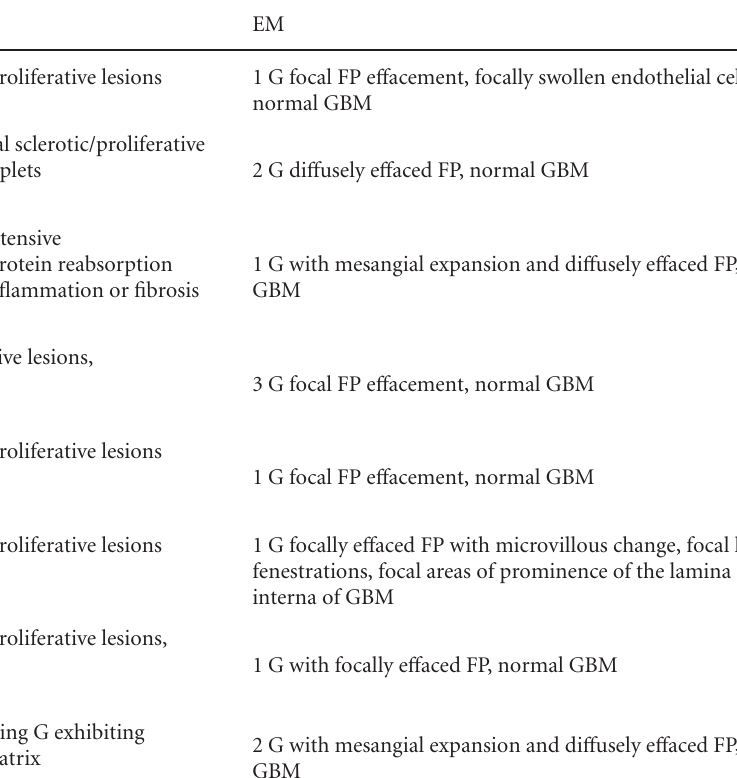
Table 1: Pathologic reports of 22 recurrent Focal Segmental Glomerulosclerosis in renal allograft recipients from 1990 to 2007 at Montefiore Medical